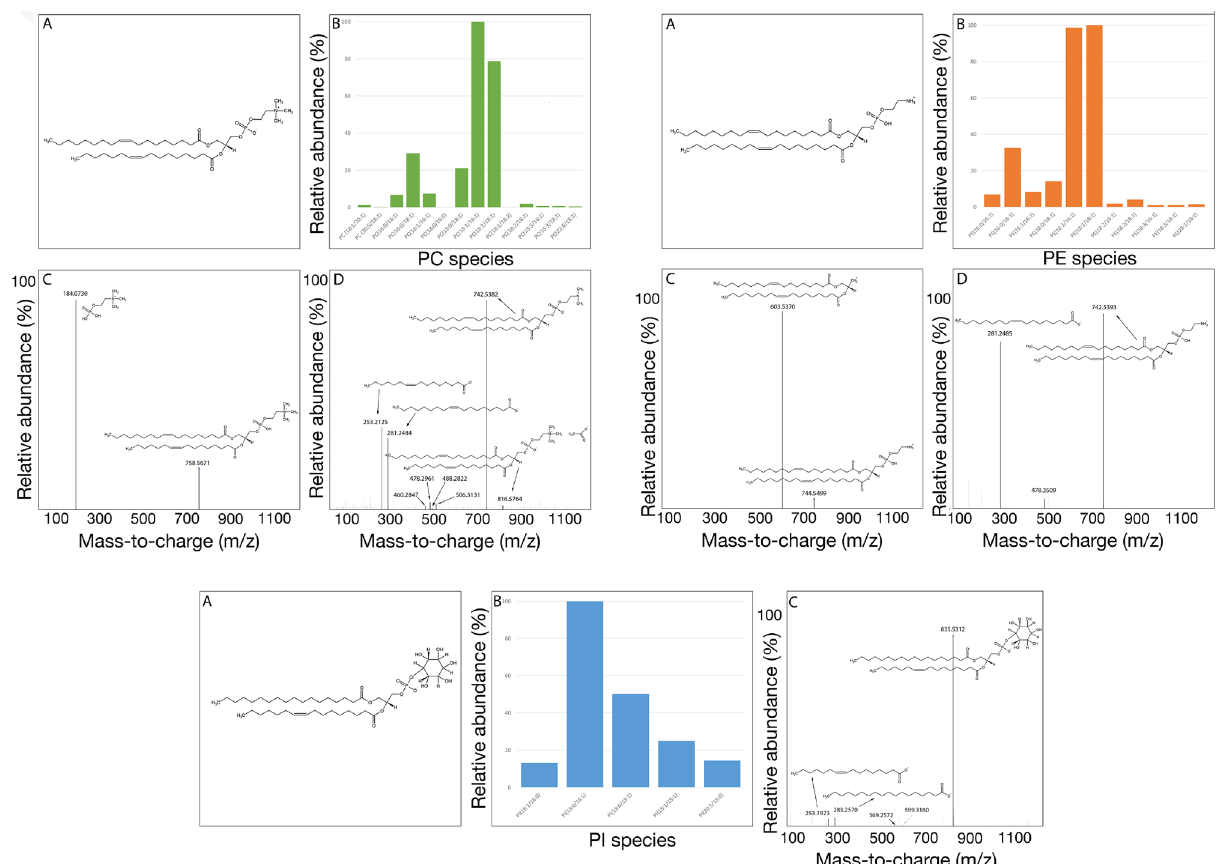
Figure 2. Major phospholipid species extracted from EPCR. A schematic structure for the most abundant species and their distribution is shown for PC ( A ), PE ( B ) and PI ( C ) species, as determined by LC–MS analysis. Fragmentation patterns in positive (PC and PE) and negative (PC, PE and PI) ionization modes are included.